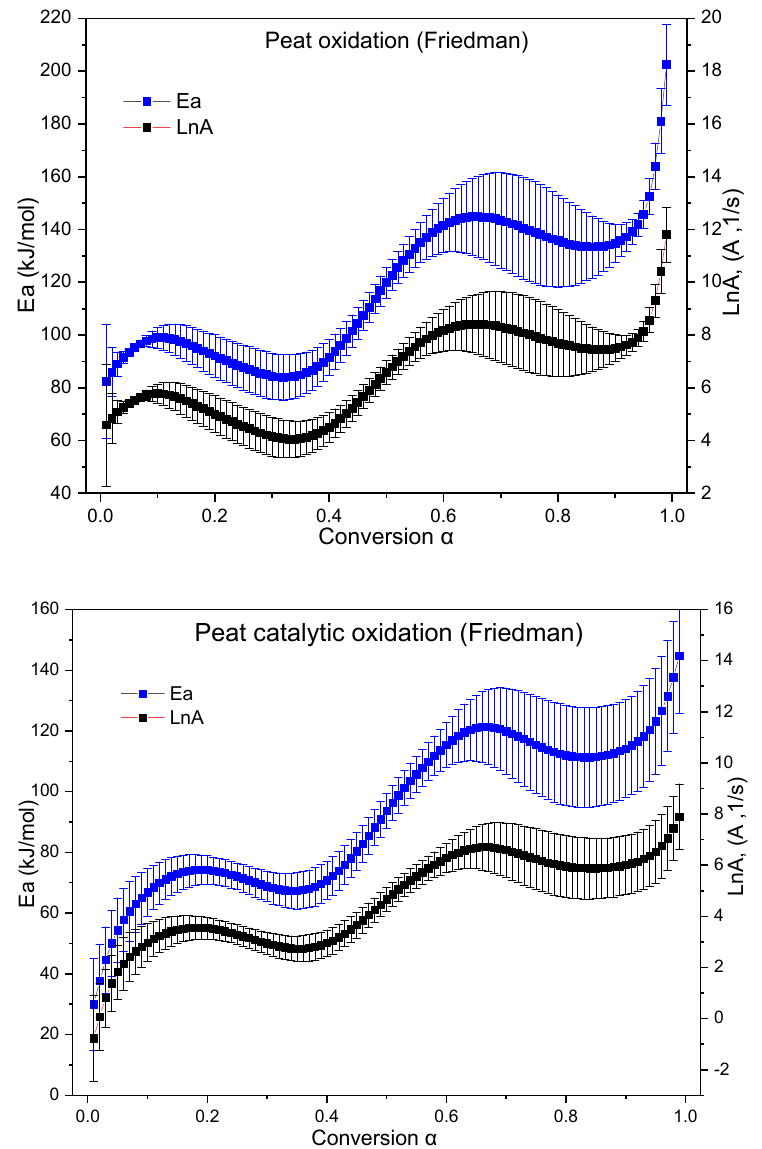
Figure 6. Peat oxidation activation energy dependency on conversion degree in the presence and absence of iron tallate obtained by the Friedman and KAS method. absence of iron tallate obtained by the Friedman and KAS